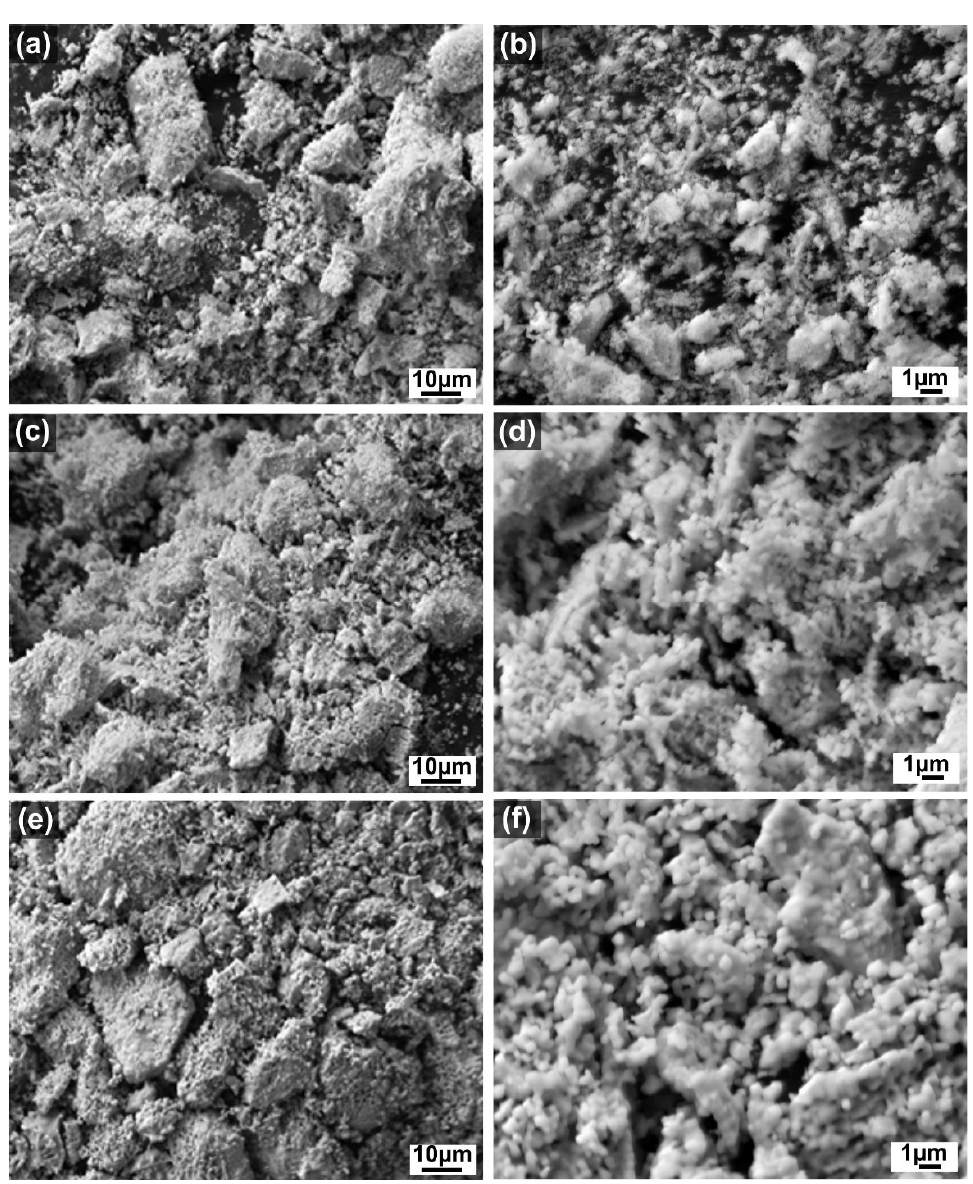
Figure 7. SEM images of the LC-SG powders calcined at different temperatures: ( a ) 1000 °C; ( b ) 1000 °C—higher magnification; ( c ) 1200 °C; ( d ) 1200 °C—higher magnification; ( e ) 1400 °C; ( f ) 1400 °C— ( b ) 1000 ◦ C—higher magnification; ( c ) 1200 ◦ C; ( d ) 1200 ◦ C—higher magnification; ( e ) 1400 ◦ C; higher magnification. ( f ) 1400 ◦ C—higher